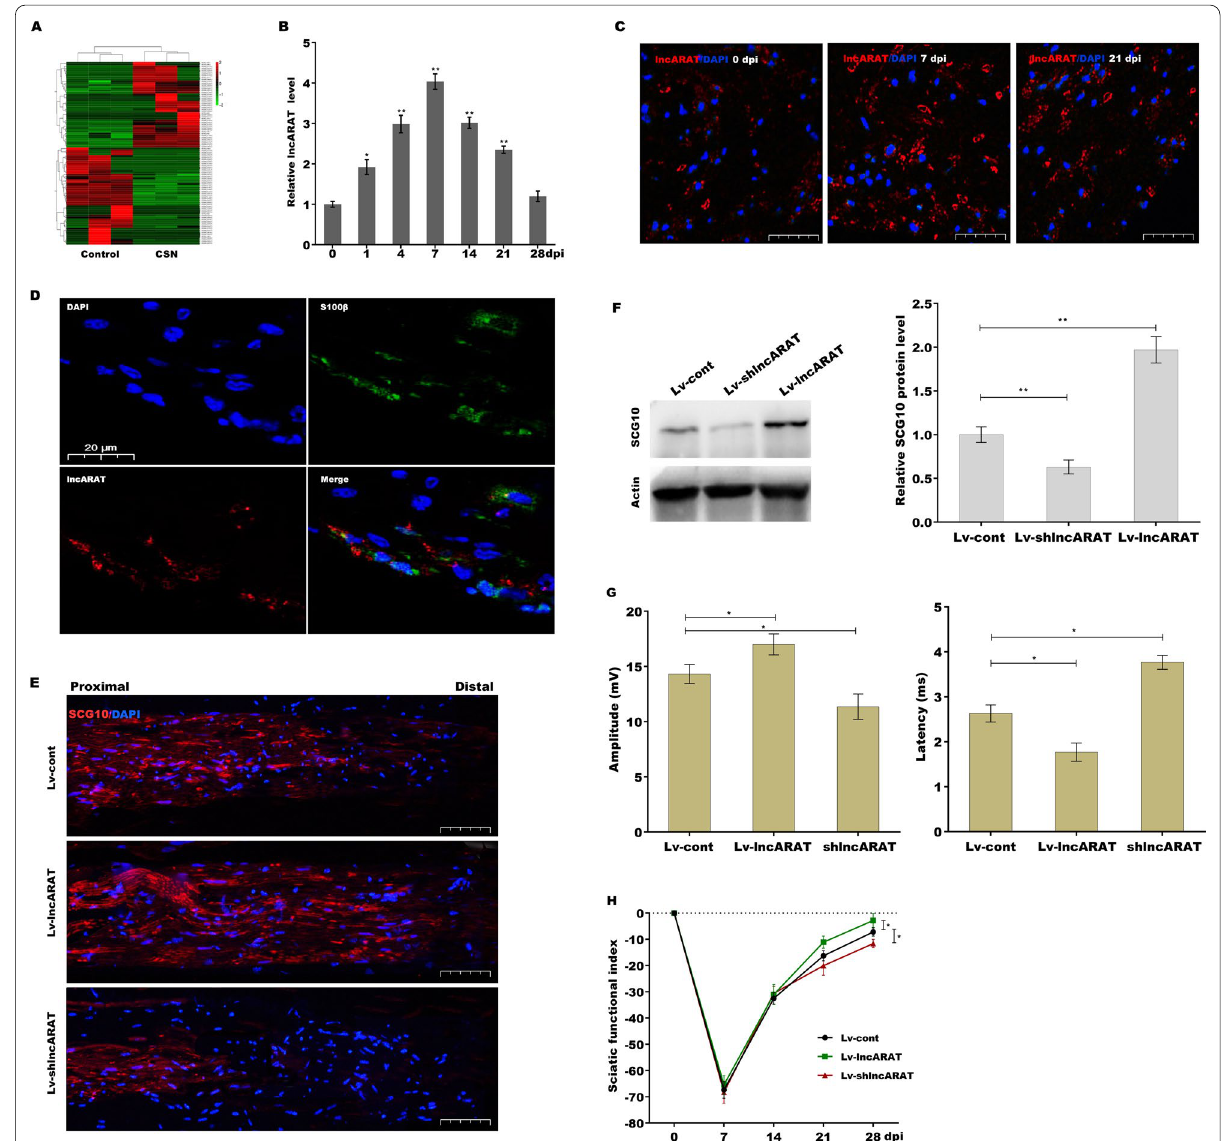
Fig. 1 LncRNA expression profile in crushed sciatic nerves. A Heatmap of DElncRNAs between crushed sciatic nerves (n nerves (n 3) 4 dpi. B qRT-PCR analysis of lncARAT levels in crushed sciatic nerves (n = 28 dpi). C Immunofluorescence (IF) analysis of lncARAT expression in cross sections of sciatic nerves 0, 7, and 21 dpi. Scale bar, 50 µm. D In situ hybridization analysis of lncARAT (red) on cross sections of sciatic nerve tissues at 4 dpi. Scale bar, 20 µm. S100 β (green) was used to indicate SCs. IF ( E ) and western blot ( F ) analysis of SCG10 in injured nerves after lncARAT overexpression or knockdown at 3 dpi. Scale bar, 50 µm. G Quantification of latencies and amplitudes of the compound muscle action potential (CMAP) after lncARAT overexpression or knockdown (n obtained with walking track analysis after sciatic nerve crush in lncARAT overexpression or knockdown rats (n